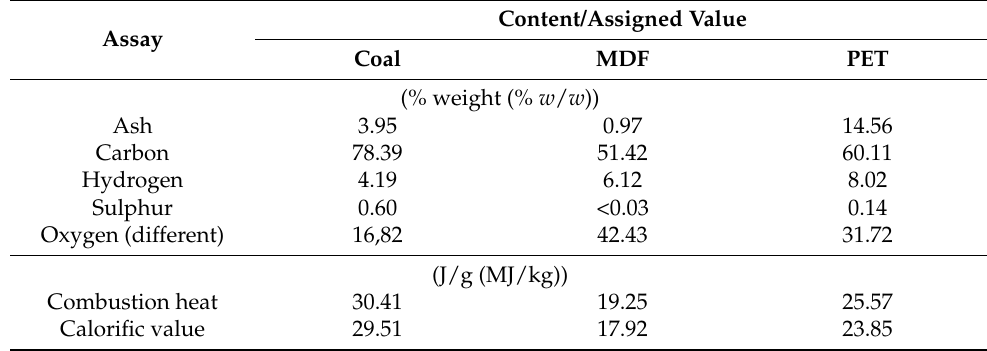
Table 2. Chemical and technical analysis of coal and co-combustion materials in the dry